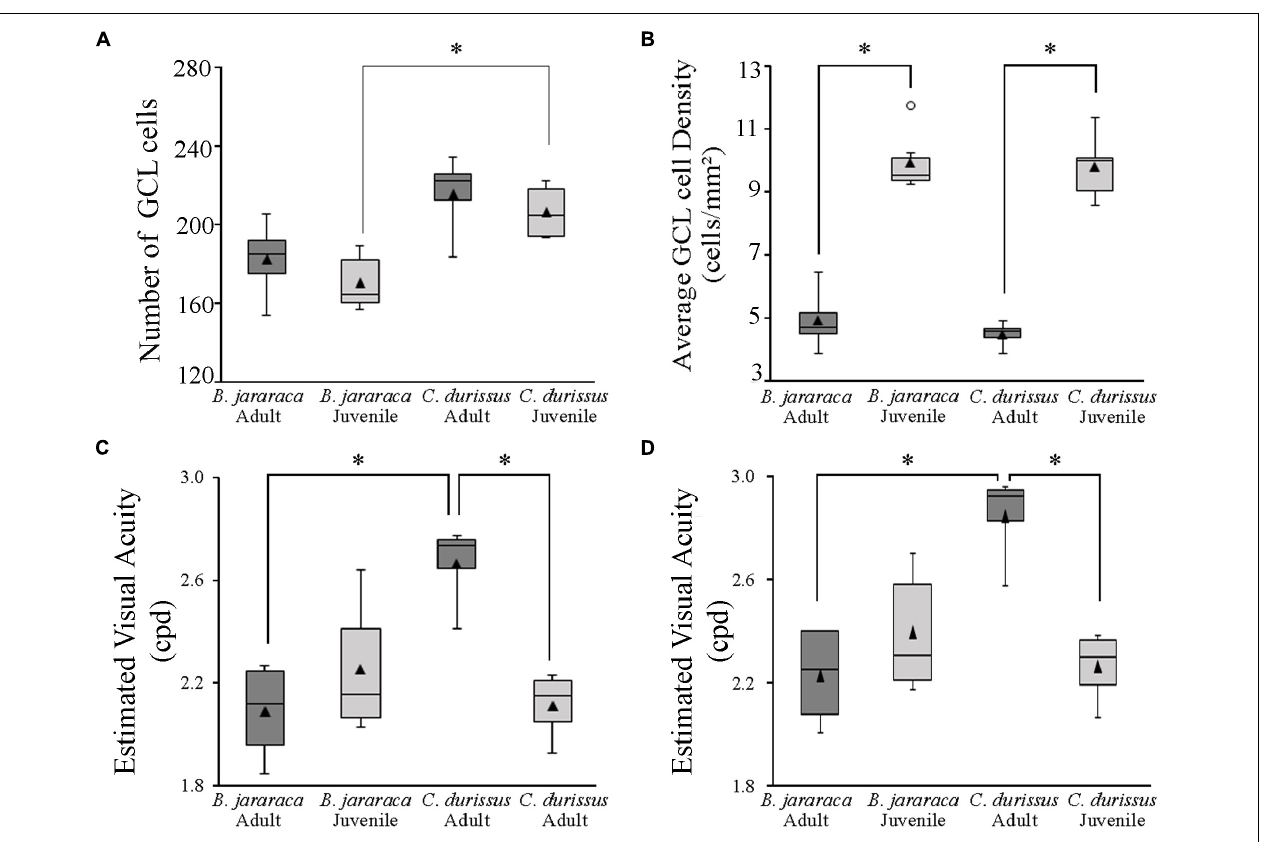
FIGURE 9 | Boxplot representations of the medians (thick black lines) and quartiles (boxes) of (A) the total number of GCL cells and (B) the mean density of GCL cells in adults and juveniles of B. jararaca and C. durissus . The values in (A,B) should be multiplied by 10 3 . The open circle in (B) indicates an outlier value. Boxplots showing the estimated visual acuity considering (C) a square array of the ganglion cells, and (D) a hexagonal array of ganglion cells, in adults and juveniles of B. jararaca and C. durissus . The mean densities are represented by the triangles. Groups with statistically significant differences are indicated by asterisk ( ∗ p <